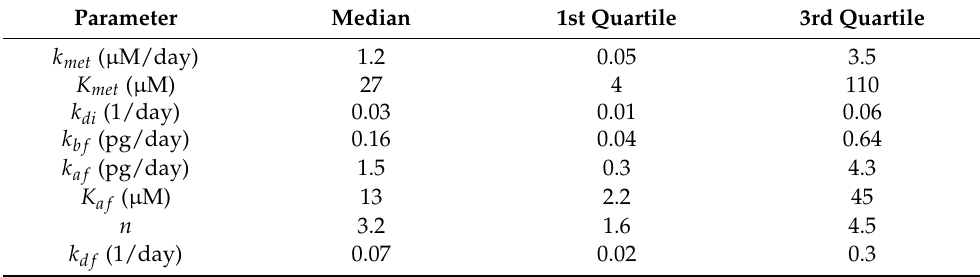
Table 5. Fetal hemoglobin model parameter estimates for HUSTLE participant